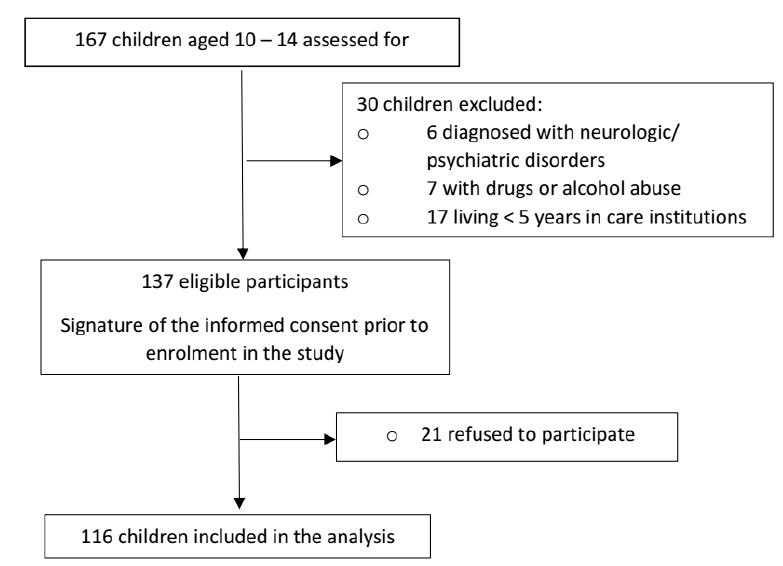
Figure 1. Flow diagram illustrating selection of participants to the study.